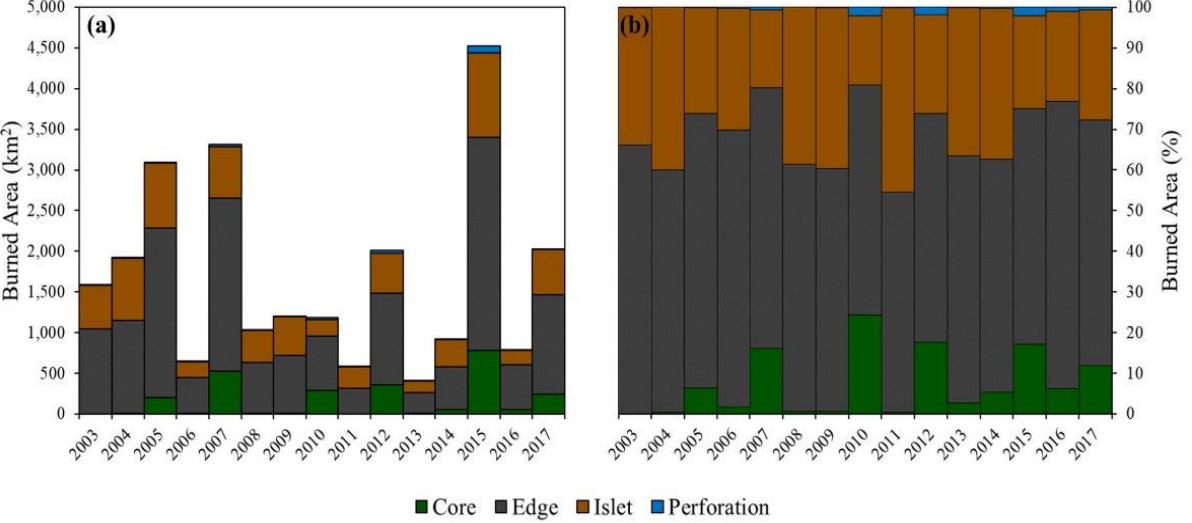
Figure 6. ( a ) Area of burnt forest per year in each fragmentation class between 2003 and 2017 in the Amazon region of Maranhão, Brazil. ( b ) The proportion of burnt forest per year in each fragmentation class between 2003 and 2017.